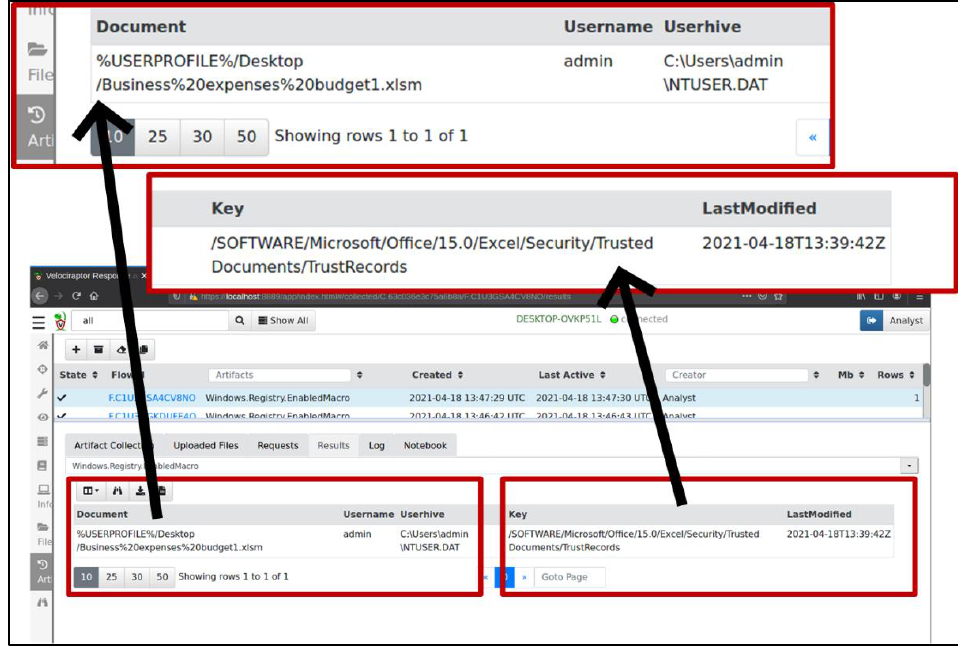
Figure 11. Validation of user action.